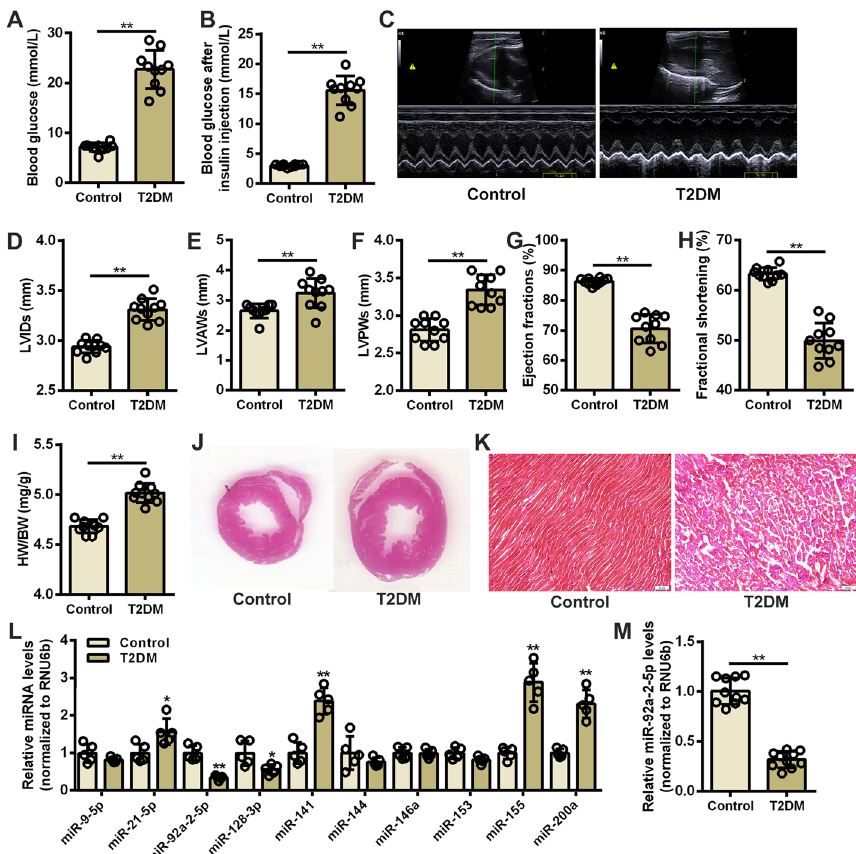
Fig. 1 Oxidative stress-responsive miRNAs were differentially expressed in DCM rat hearts. A Detection of random blood glucose levels in rats. n 10 in each group. ** P < 0.01. B Detection of blood glucose level in = rats after insulin injection. n 10 in each group. ** P < 0.01. C Representative echocardiographic images of = the rat hearts. D - H Evaluation of the mean values of LVIDs, LVAWs, LVPWs, EF, and FS in rats. n 10 in each = group. ** P < 0.01. I Determination of the heart weight/body weight (HW/BW) ratio in rats. n 10 in each = group. ** P < 0.01. J Representative images of H & E staining in rat heart tissues from control and T2DM groups. K Representative images of Masson’s staining in rat left ventricular tissues. Scale bar 50 μm. L Screening of = oxidative stress-responsive miRNAs in rat left ventricle tissues. n 5 for each group. * P < 0.05, and ** P < 0.01 = vs. control group. M Relative expression level of miR-92a-2-5p in rat left ventricular tissues. n 10 in each = group. ** P <